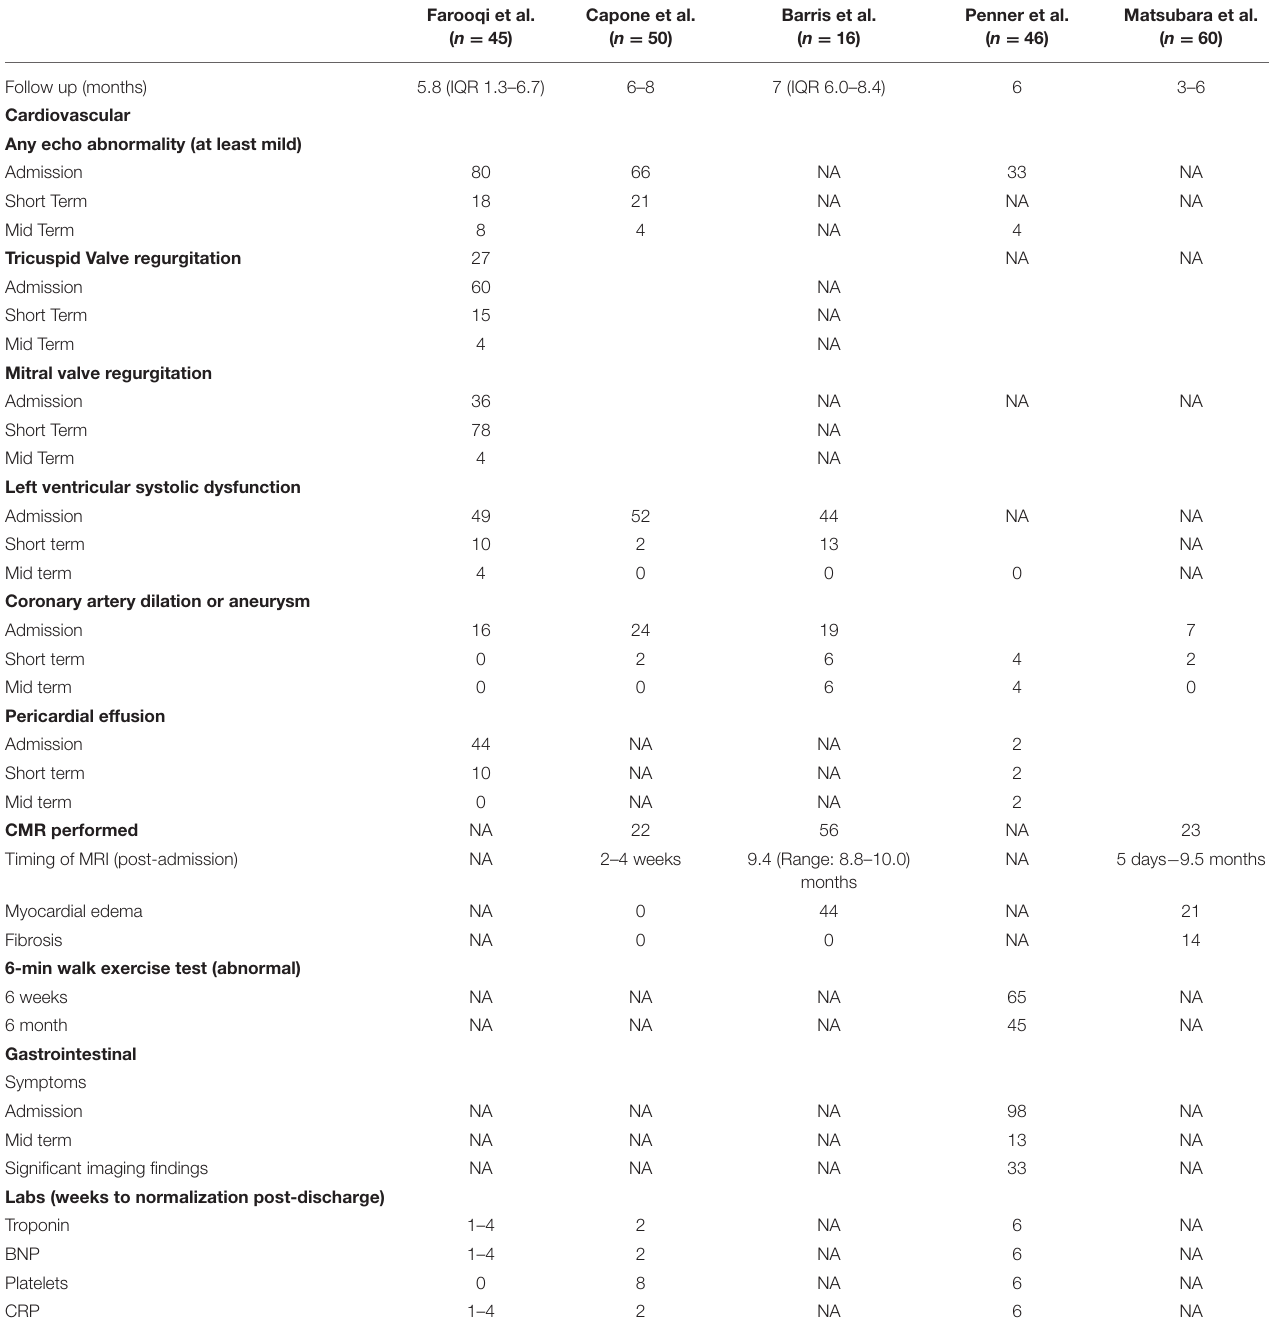
TABLE 2 | Longitudinal Outcomes MIS-C.